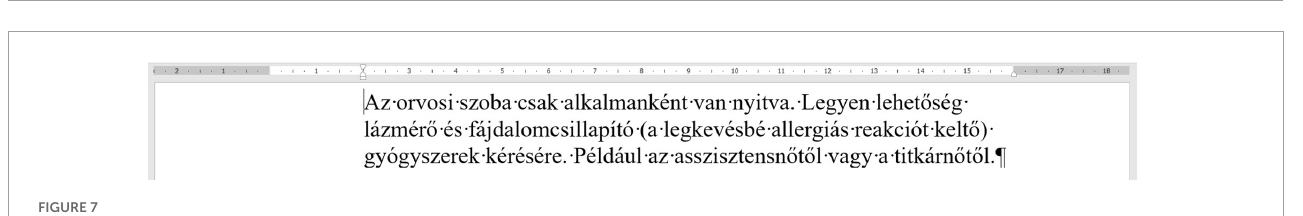
FIGURE7 The ruler shows that there is a left indent configured, a single paragraph, and no extra space